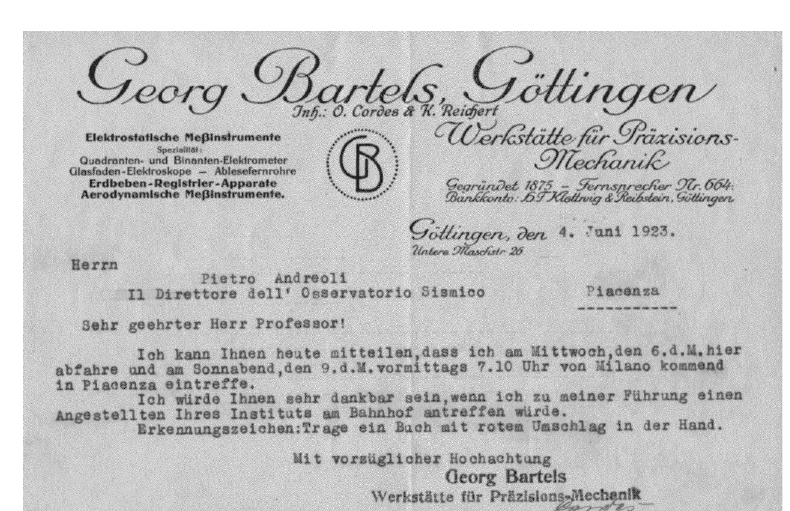
Fig. 6. Letter of the Bertels farm concerning the installation of the Wiechert seismograph at the Alberoni